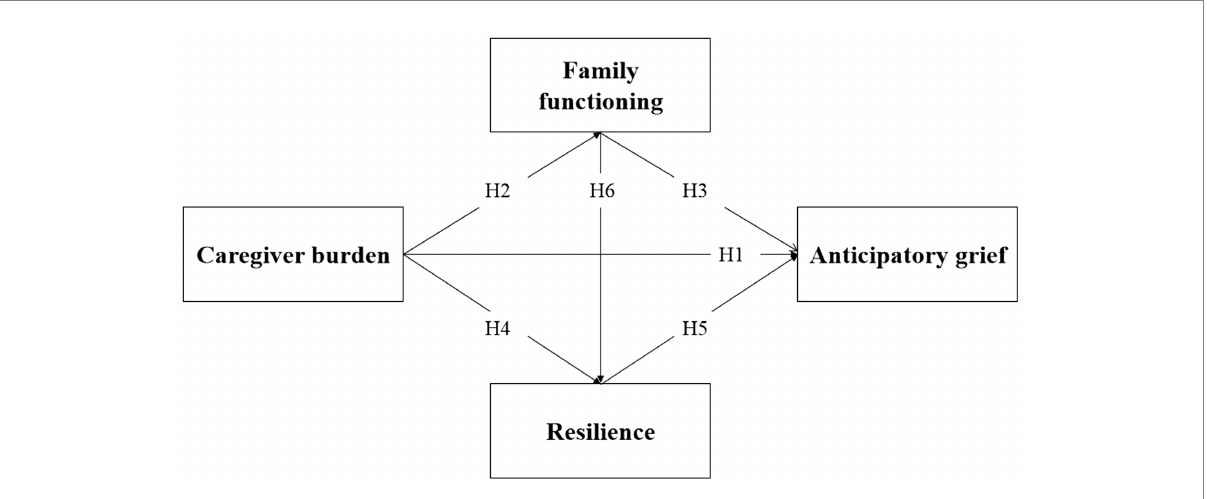
FIGURE 1 A hypothetical model of the relationship between variables. Influence of caregiver burden on anticipatory grief through family functioning and